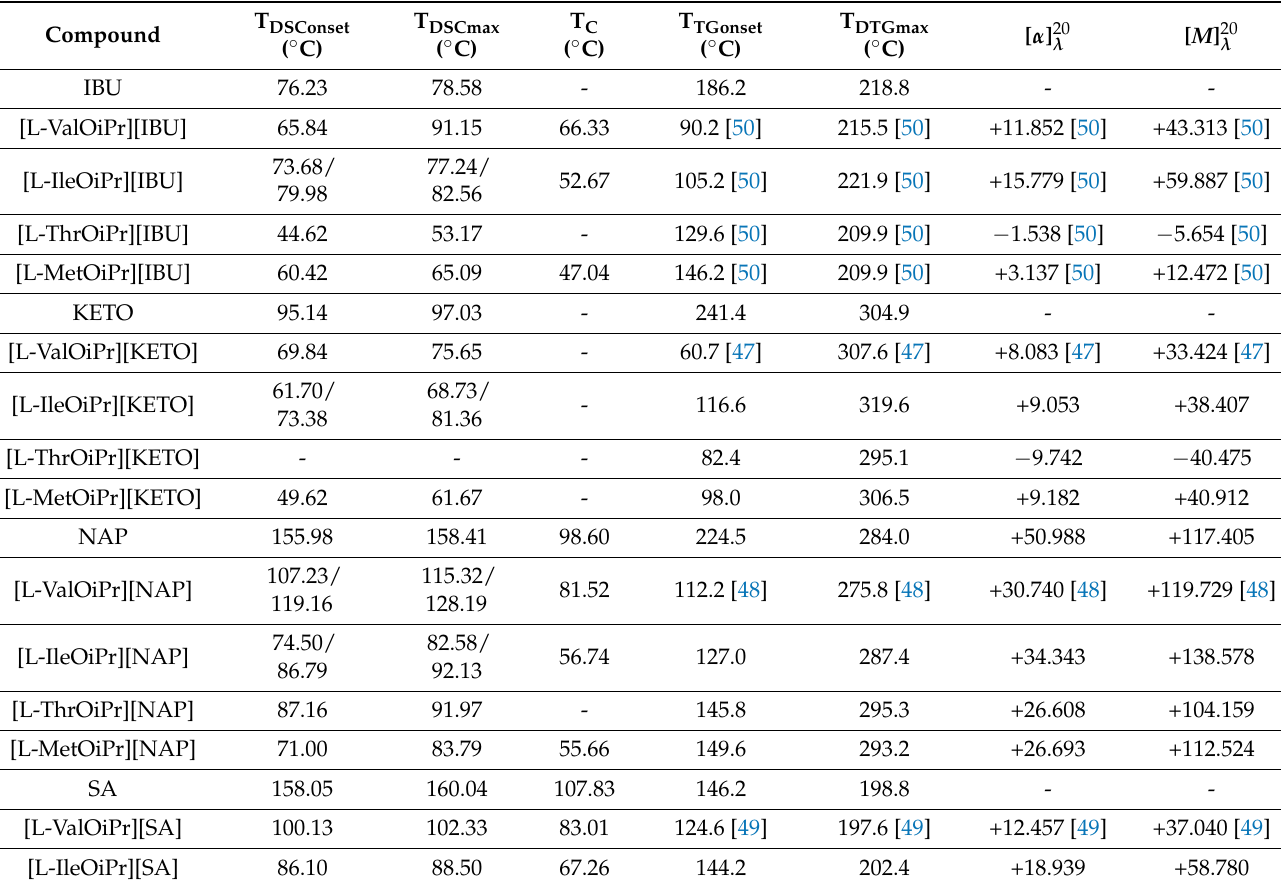
Table 1. Melting points, thermal stability, and specific and molar rotation for NSAIDs and their amino acid isopropyl